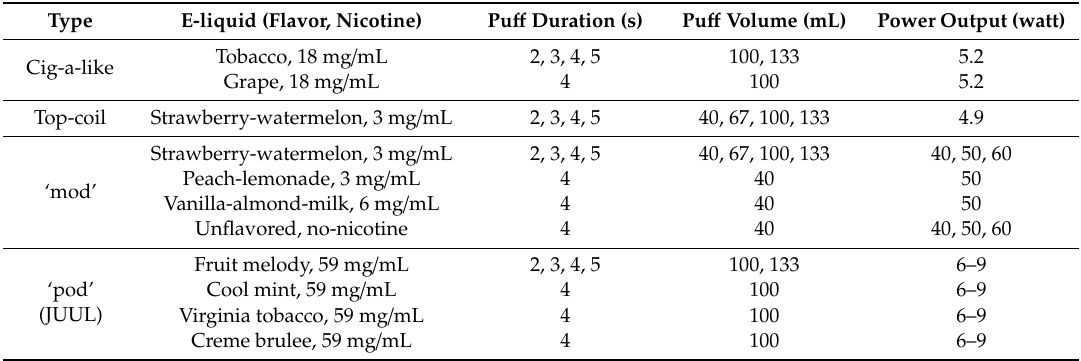
Table 1. E-cigarette brands, e-liquid types, and e-cigarette aerosol generation conditions used in this study 1